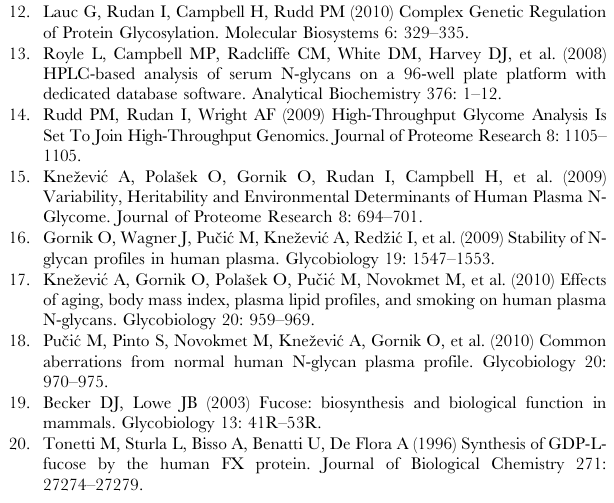
Table S2 Desialylated glycan traits (DG1-13, FUC-A, FUC-C) and their associations with FUT6 , FUT8 and HNF1 a SNPs showing their effect sizes (Beta) in standard deviation units (with standard errors) and p-values. The fucosylation status of each trait is also